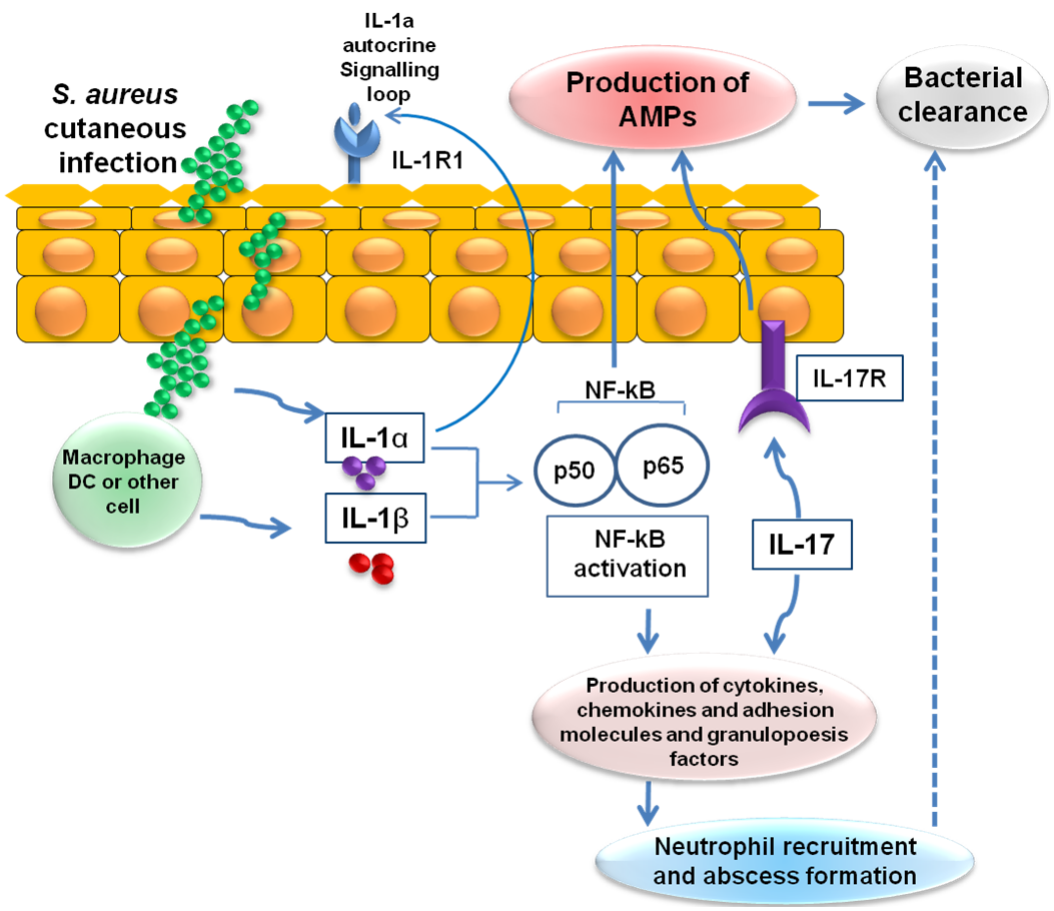
Figure 2. IL-1- and IL-17-mediated cutaneous immune response against S. aureus